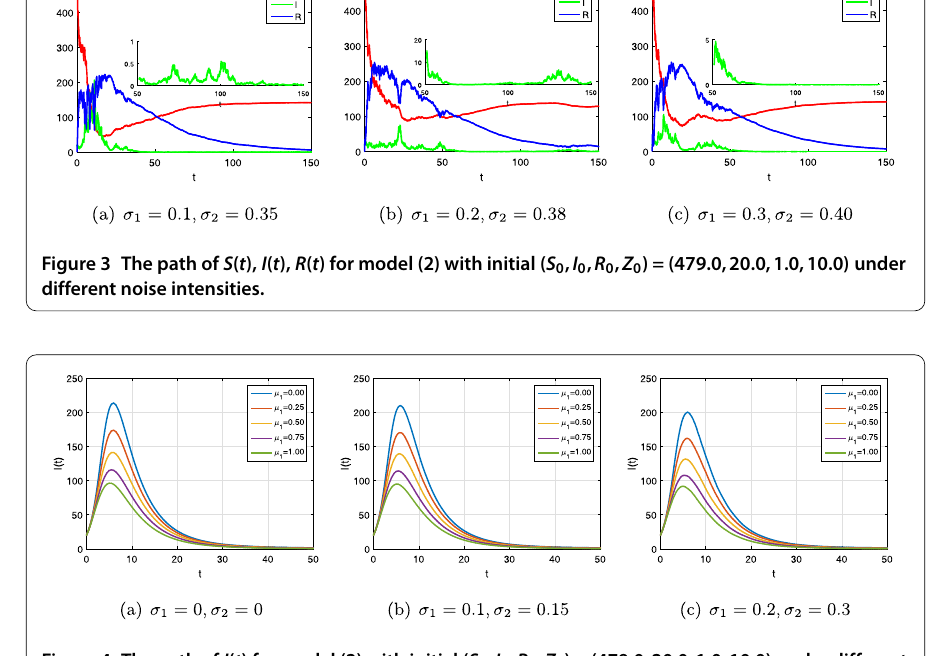
The initial population size as: S () = , I () = , R () = , Z () = . We calcu- = . > , the disease-free equi- late the basic reproduction number R  = (cid:2)β μ ( μ + γ + δ ) librium E  = (.,.,.,.) and the infected equilibrium E ∗ = (.,.,.,.). For a clear comparison with the path of epidemic model (), we show the path of S ( t ), I ( t ), R ( t ) for deterministic model () in Figure . Example . (Stochastic endemic dynamics) In Figure , we choose σ  = ., σ  =